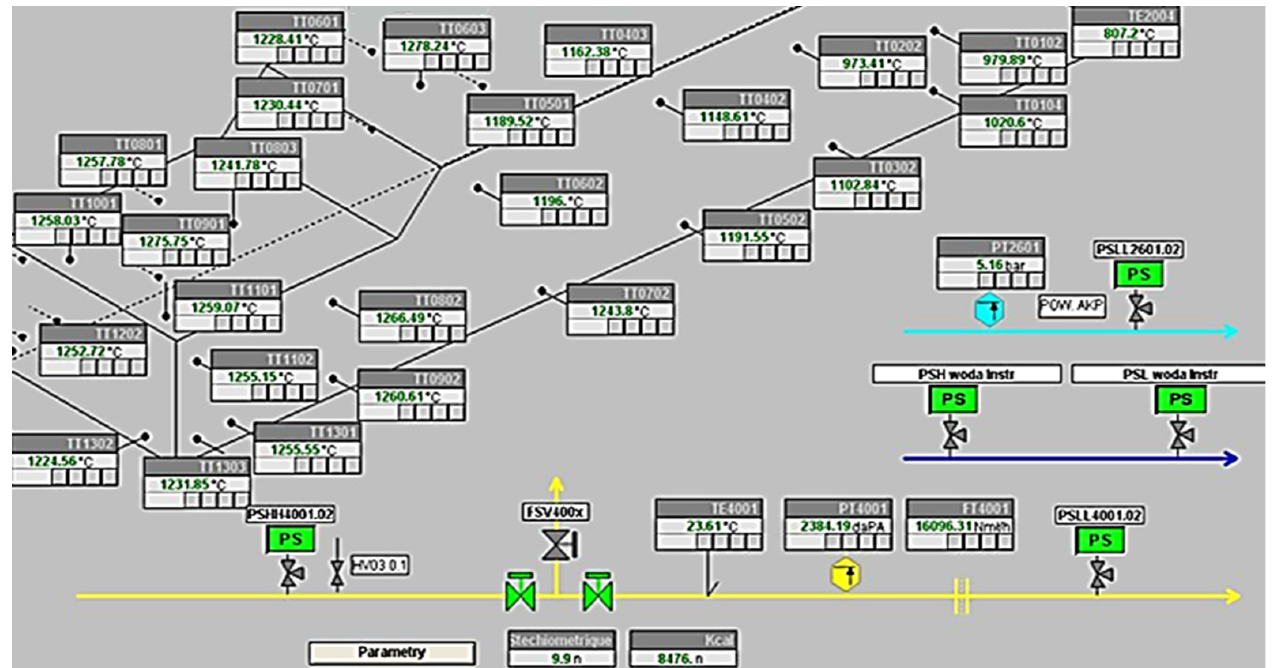
Figure 5. The furnace has a gradual distribution of heating temperatures. Source: own study.